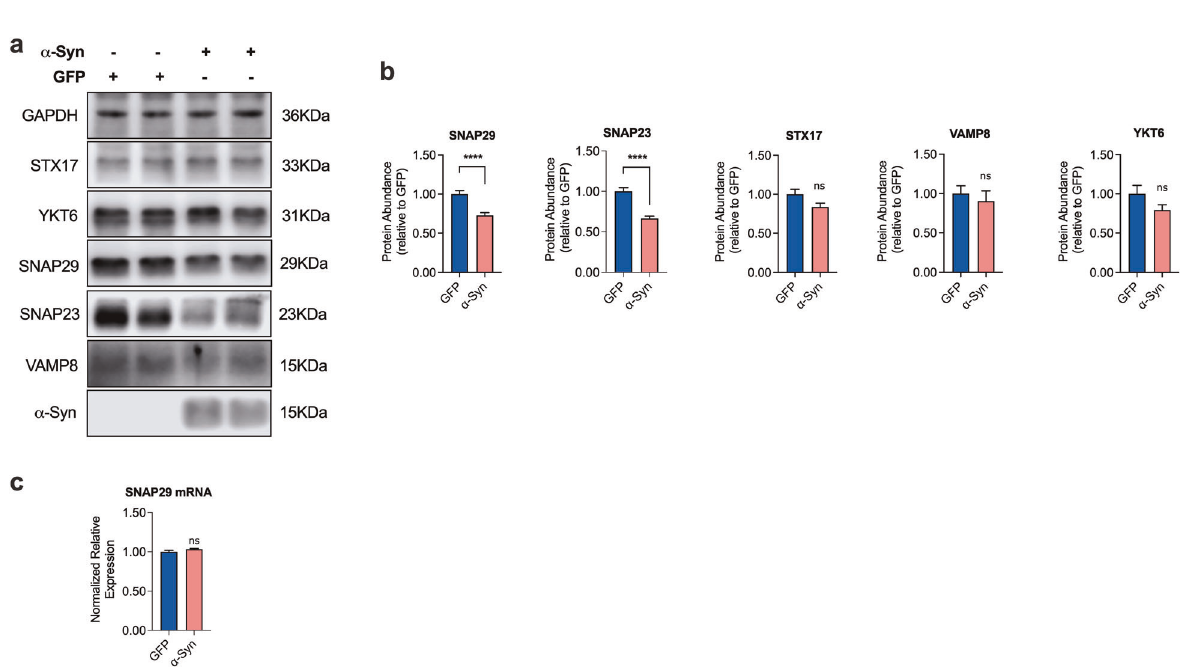
Fig. 3 α -Syn overexpression reduces the abundance of SNAP29 in cultured human DA neurons. a , b Western blot and bar graphs illustrating the SNARE proteins STX17, YKT6, VAMP8, SNAP29, and SNAP23 in α -Syn- and GFP-transduced neurons. α -Syn overexpression speci fi cally leads to a decreased protein abundance of the SNAP25 family members SNAP23 and SNAP29, whereas the other SNARE proteins remain unchanged ( n = 6/condition, n = 11 for SNAP29). c Bar graph showing similar levels of SNAP29 mRNA expression in α -Syn-transduced neurons as compared to GFP-transduced cells ( n = 3/condition). For comparison of the means, a two-tailed unpaired t-test was used in b , c ; **** P < 0.0001; Data are shown as means ±